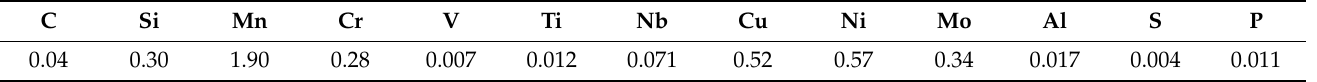
Table 2. Chemical composition of X100 pipeline steel (mass, %).